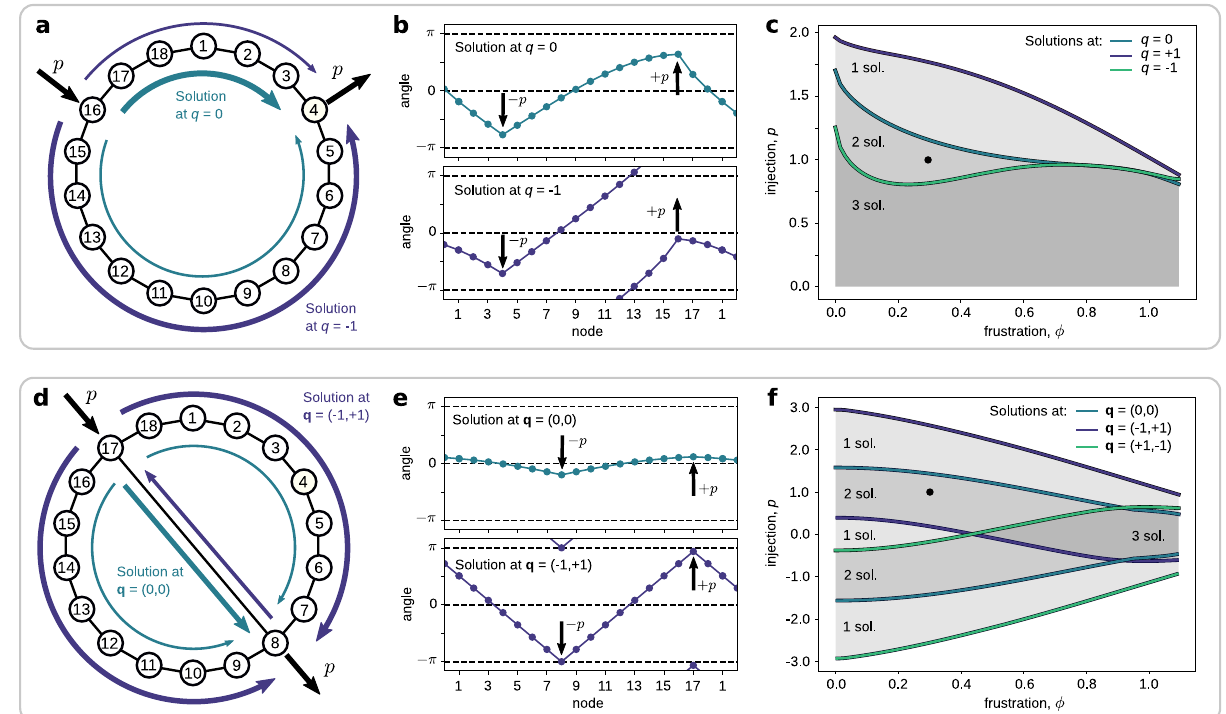
Fig. 3 | Anomalous behaviors inthe Kuramoto – Sakaguchimodel. Illustration of the anomalous behaviors identi fi ed for the Kuramoto – Sakaguchi model on a cycle network ( a – c ) and a two-cycle network ( d – f ), with unit coupling weights. a Qualitativedistributionsof fl owsoveracycleof n =18oscillators,withcommodity injection+ p (resp. withdrawal − p ) at node 16 (resp. 4). The arrows of two different colors visualize different fl ow solutions, with different winding numbers. b Angles correspondingtothetwosolutionsofpanel a .Oneclearlyseesthat,forthesolution at q =+1, the angles wrap around the circle, but not in the solution at q =0. c Boundaries (colored curves) of the existence regions for solutions at different